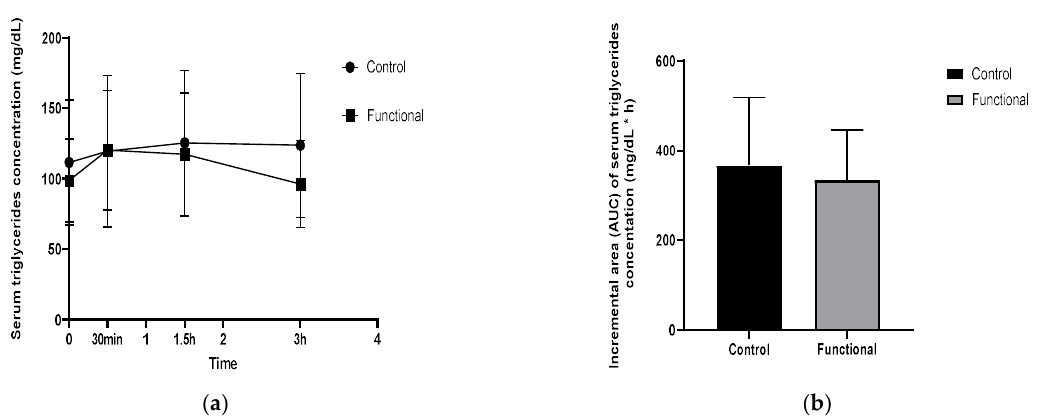
Figure 4. ( a ) Incremental changes in postprandial serum triglycerides (TG) concentration. ( b ) The incremental area under the curve (iAUC) for postprandial serum TG.